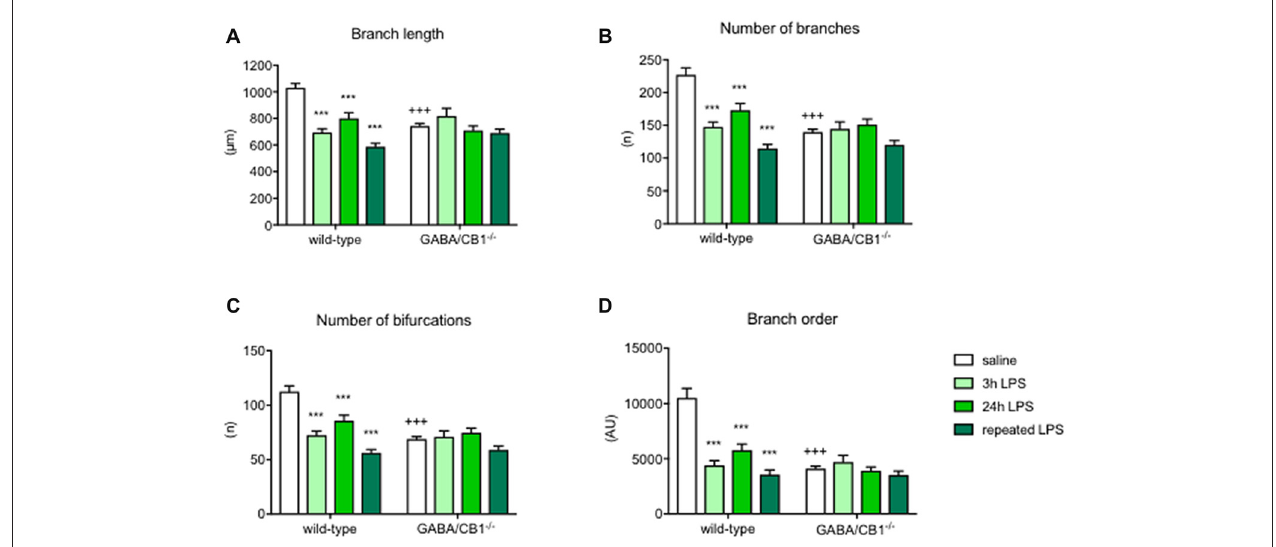
FIGURE 4 | Microglia branch morphology in the hippocampus of WT and GABA/CB1 − / − mice . Data of the control groups (saline-treated) are pulled together separately to the genotypes and shown as white bars. Light green bars represent data received 3 h after the intraperitoneal LPS-treatment, Intensive green bars represent data received 24 h after the intraperitoneal LPS-treatment and dark green bars represent data received 24 h after the fourth daily intraperitoneal LPS injection. Extent of branching is shown as (A) Branch length (B) Number of branches. The complexity of microglia branching is shown as (C) Number of bifurcations and (D) Branch order. n = 48–58. ∗∗∗ p < 0.001 difference detected by Bonferroni’s t -test between LPS and saline-treated mice from a respected control group; +++ p < 0.001 difference between WT and GABA/CB1 − / − mice with the same treatment, both using two-way ANOVA followed by Bonferroni’s t